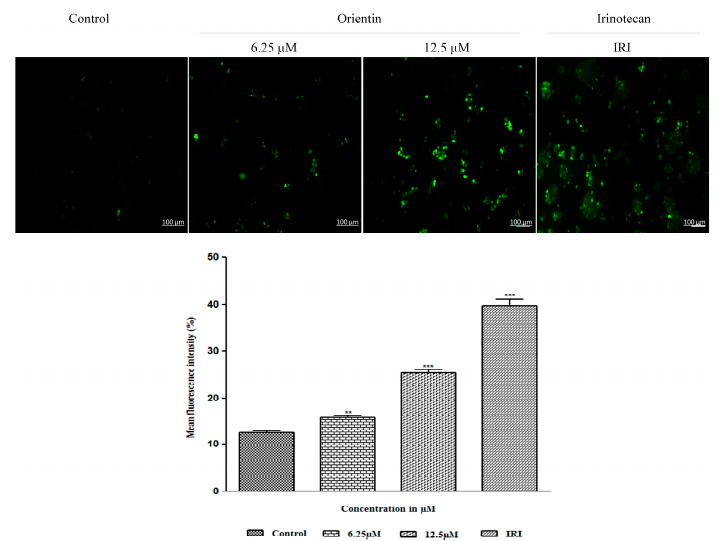
Figure 7. Intracellular reactive oxygen species (ROS) accumulation in HT29 cells by orientin. The fluorescent microscopic images of intracellular ROS generated in HT-29 cells treated with different concentrations of orientin and standard irinotecan for 24 h. The fluorescent images were taken with a fluorescence microscope and analyzed with Image J software. Data are shown as mean ± SD of three parallel independent experiments. ** p < 0.01 and *** p < 0.001 vs. control.